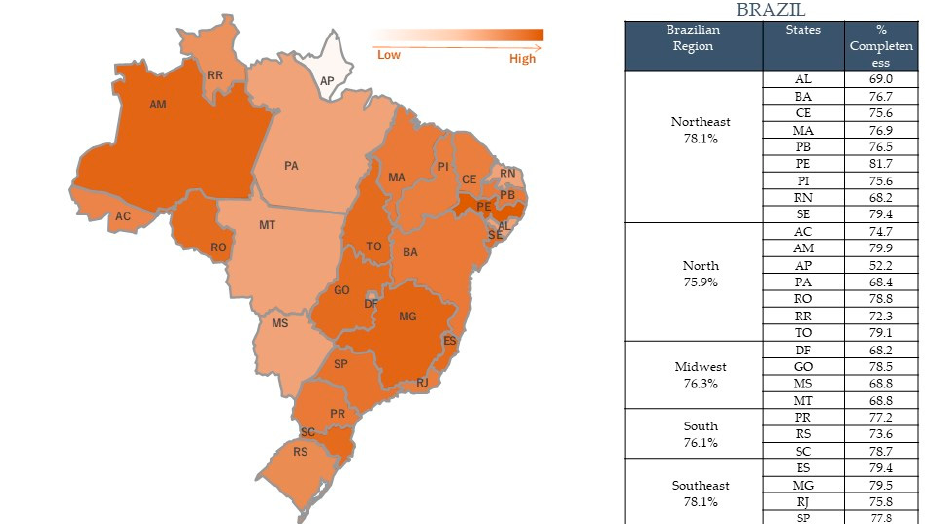
Figure 3. Total completeness % of all the States by region.